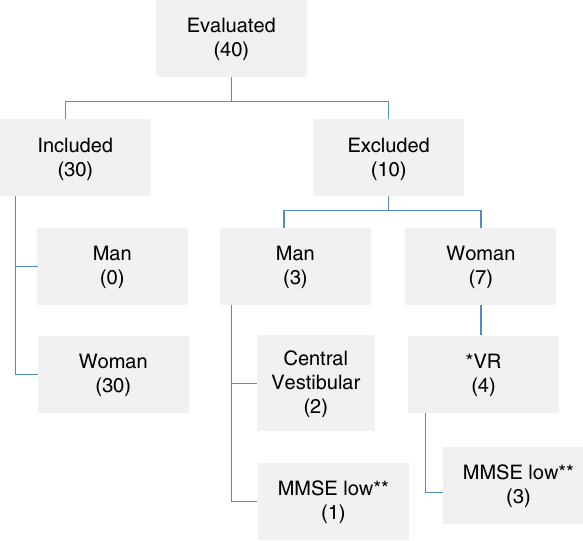
Flowchart of the sample (*VR, conventional ves- tibular rehabilitation in progress; **MMSE, Mini-Mental State